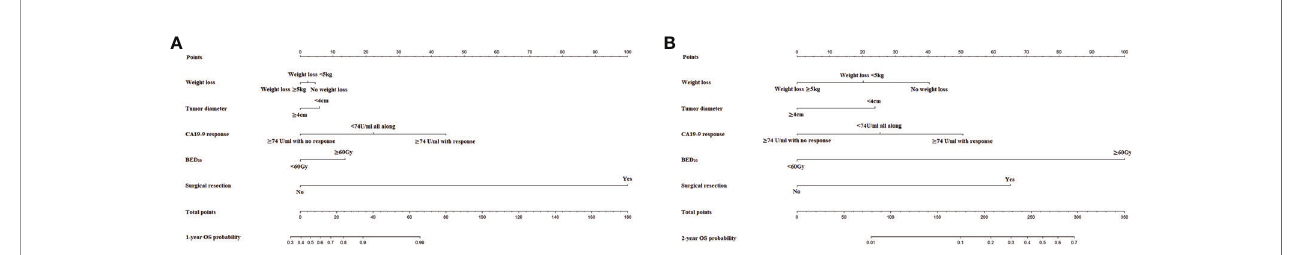
FIGURE 1 | (A) The nomogram for predicting probability of OS at 1 year and (B) 2 years.